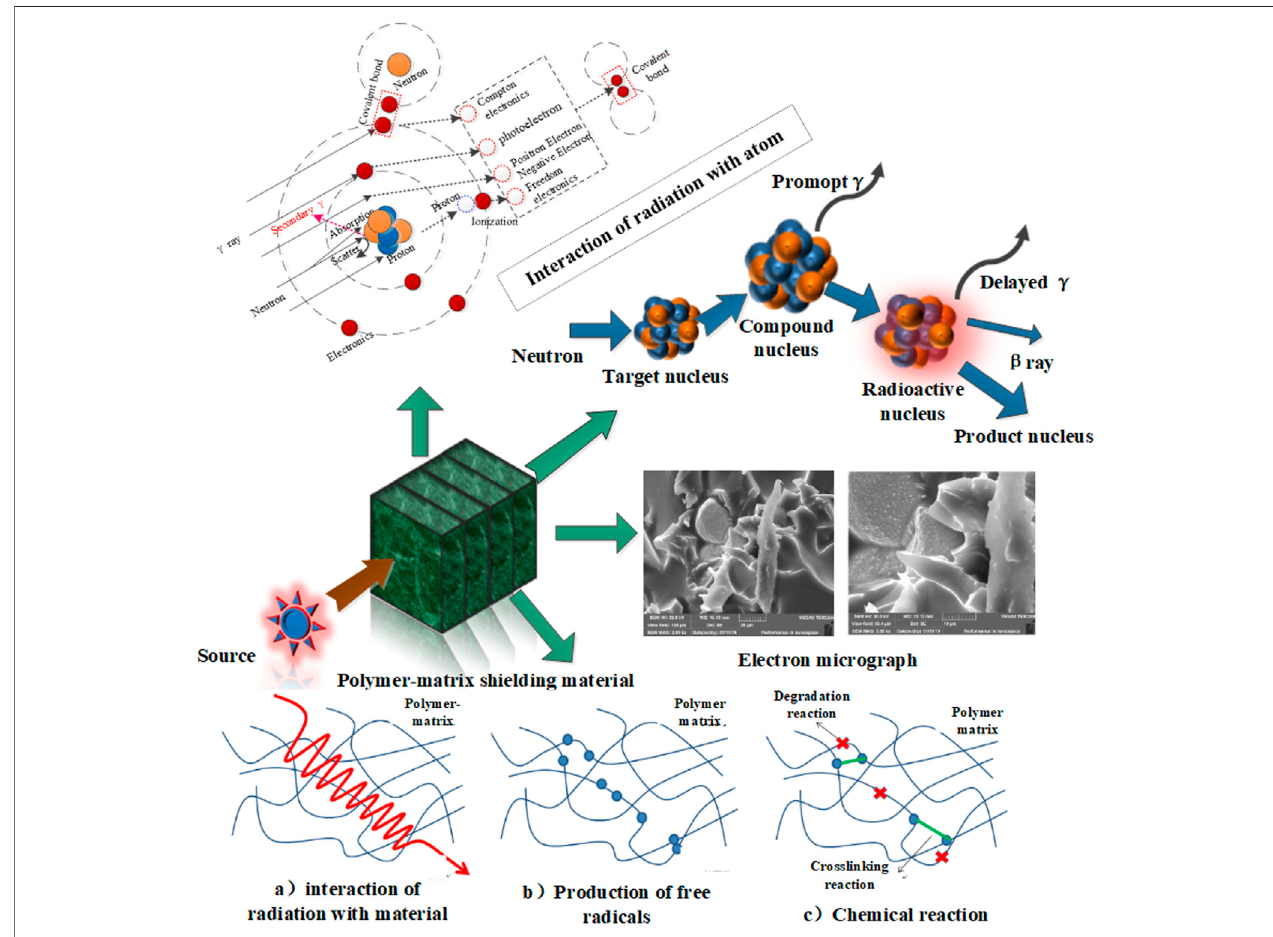
FIGURE 1 | Schematic diagram of the interaction of polymer-matrix nuclear radiation shielding materials with rays and the resulting effects.